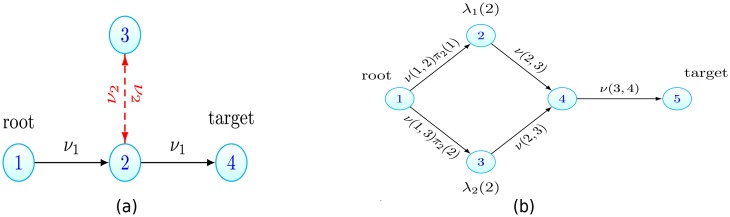
Example systems for which our extended results, given in the Extensions section, are useful.(a) Walks containing cycles can seed the target. The walk of length 4 that traverses the red edges with transition rate ν2 can still be faster than the length 2 path. See (12). (b) Incorporating a distribution of fitnesses. Take the path graph from Fig 2. Suppose that instead of a fixed λ(2), after the first transition cells have fitness λ1(2) or λ2(2) with probabilities π2(1), π2(2), with λi(2) < λ. Then instead of the original path graph, we consider the enlarged graph shown here, where vertex 2 is replaced by two vertices with associated growth rates λ1(2), λ2(2). The transition rates to these new vertices are ν(1, 2)π2(i), where ν(1, 2) is the transition rate between vertices 1 and 2 in the original setting. All results can then be applied to the new enlarged graph.